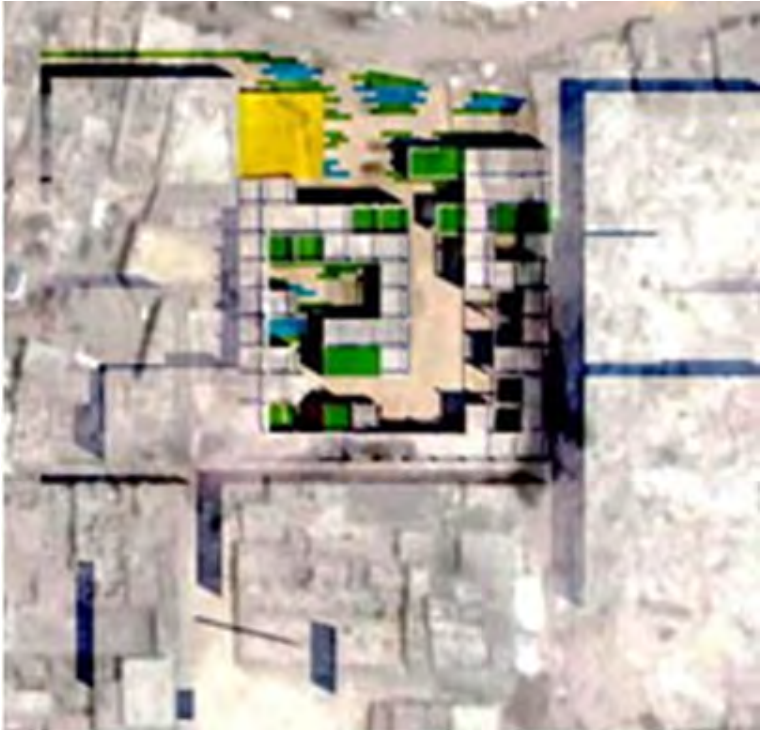
Figure 13. Showing the project within its surrounding context (“Ahmed Shemisah’s” Project)